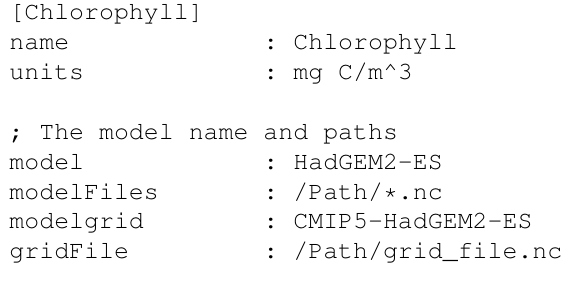
Figure 2. The structure of the BGC-val repository. The principal directories are shown as rectangles, with the name of the directory in bold followed by the key files contained in that directory. Individual files in the head directory are shown with rounded corners. The evaluation scripts and the configuration directory are shown in purple. The primary Python modules are split into four directories, shown in green rectangles. The three user-configurable Python modules are shown as blue rectangles. The licence, README, and setup files are shown in